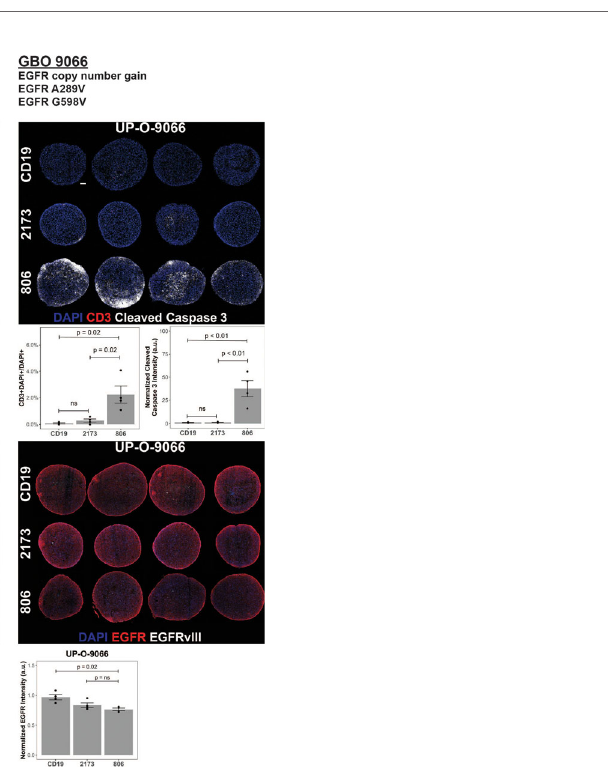
FIGURE 5 | 806 CAR T activity in heterogeneous GBOs highlights cross-reactivity of 806 binder against oncogenic EGFRs. CAR T coculture with GBOs was used to demonstrate anti-EGFR activity. (A) EGFR alterations identi fi ed in each GBO line. (B) Immuno fl uorescence images of CAR T cells engrafted GBOs, for four organoids per condition, 9057 (left) and 9066 (right). Blue = DAPI; red = CD3 + ; white = cleaved caspase 3 + (CC3 + ), scale bar = 100 µm. (C) Quanti fi cation of CD3 + cells (left) and CC3 + cells (right) showing antitumor activity from the 806 CAR T cells. (D) Immuno fl uorescence images of CAR T cell targets in GBOs, for 9057 (left) and 9066 (right). Blue = DAPI; red = EGFR + ; white = EGFRvIII + , scale bar = 100 µm. (E) Quanti fi cation of EGFR + (left) and EGFRvIII + signals (right) showing antitumor activity from the 806 CAR T cells. Error bars are ± standard error. ns, p >